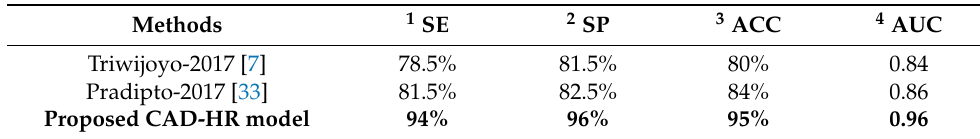
Table 7. Performance of the developed CAD-HR system compared to other DL systems on 9,500 samples.